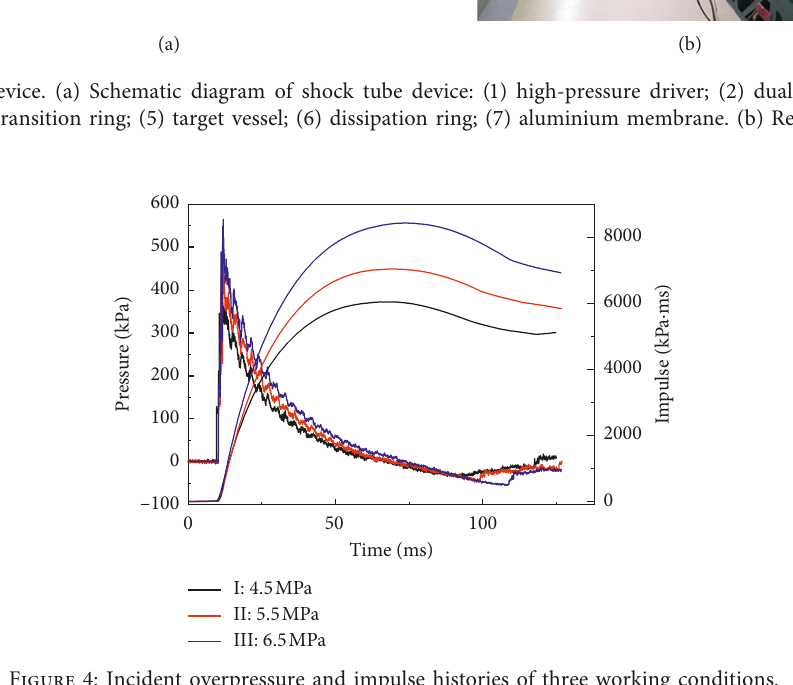
Figure 4: Incident overpressure and impulse histories of three working